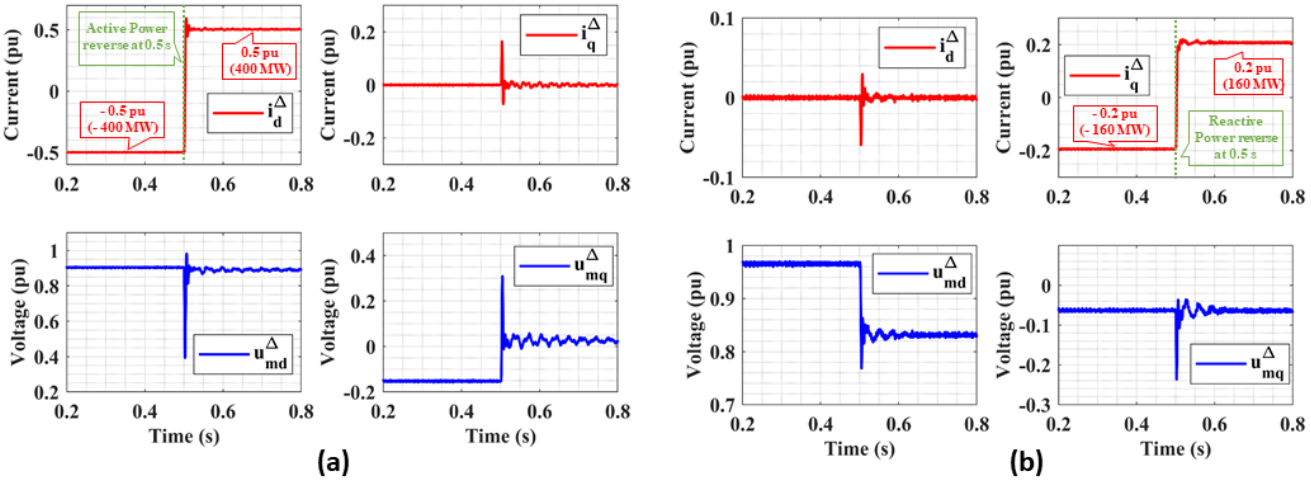
Figure 20. Change at the time instance t = 0.5 s in: ( a ) active power reference from − 0.5 p.u. to 0.5 p.u.; ( b ) reactive power reference from − 0.2 p.u. to 0.2 p.u.